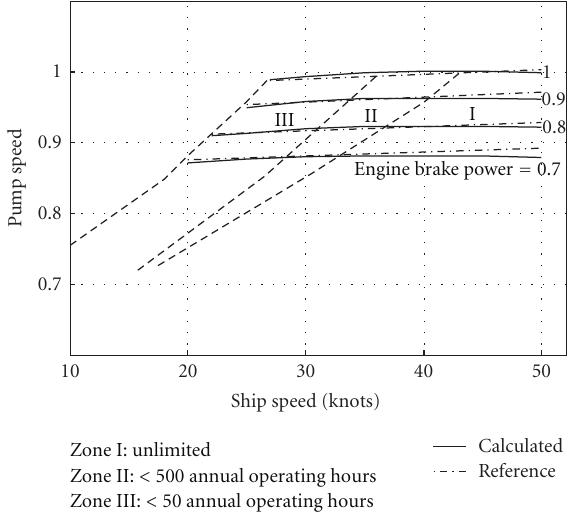
Figure 17: Pump speed versus ship speed waterjet map.